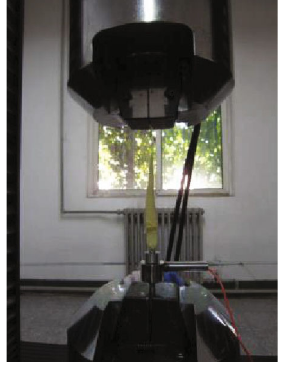
Figure 30: Tensile test.